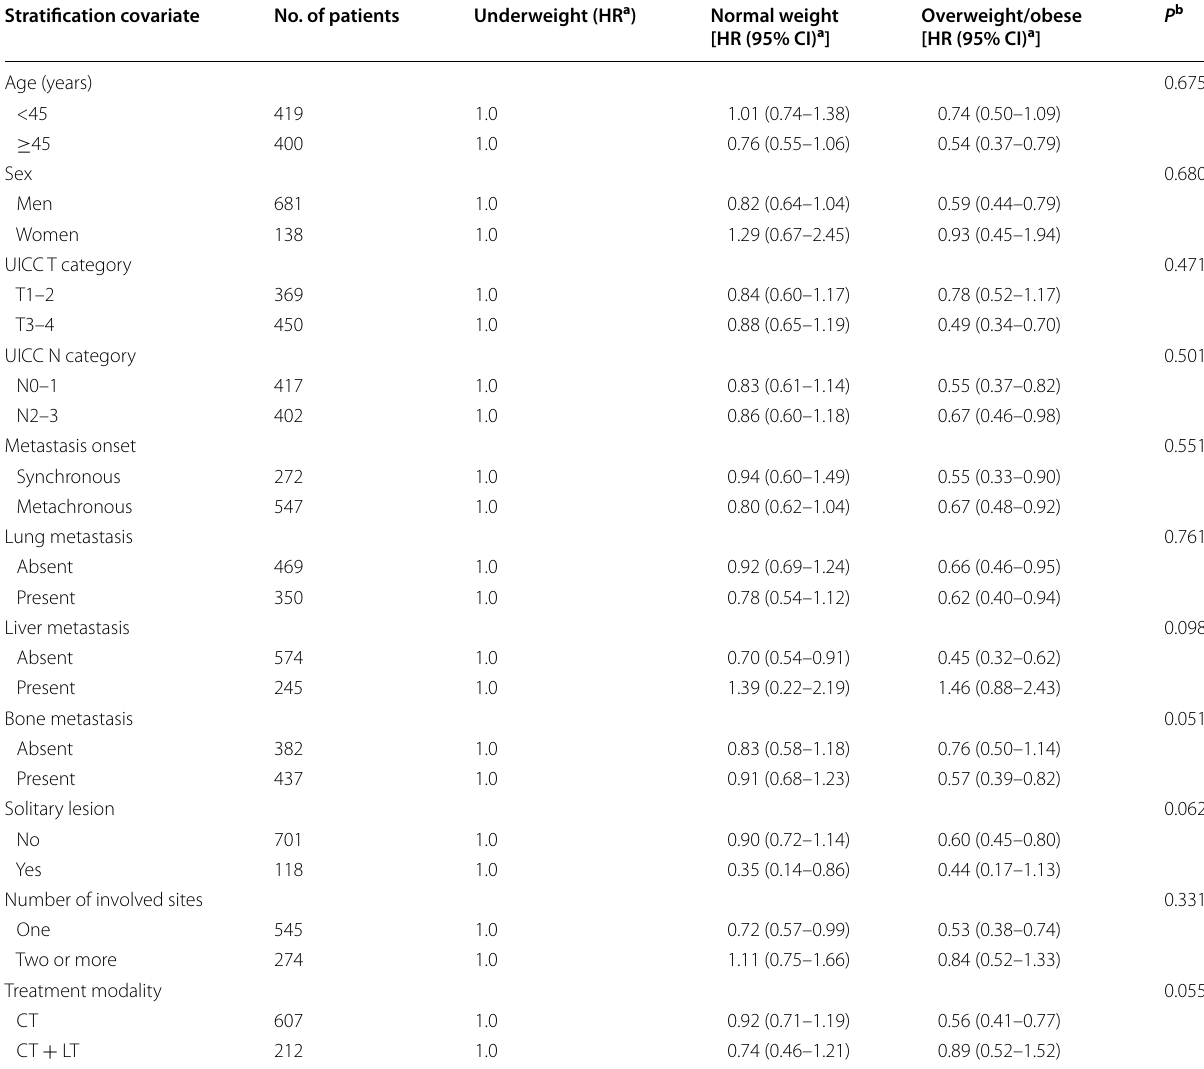
Table 4 Multiple-adjusted HRs for OS by baseline BMI level, stratified by